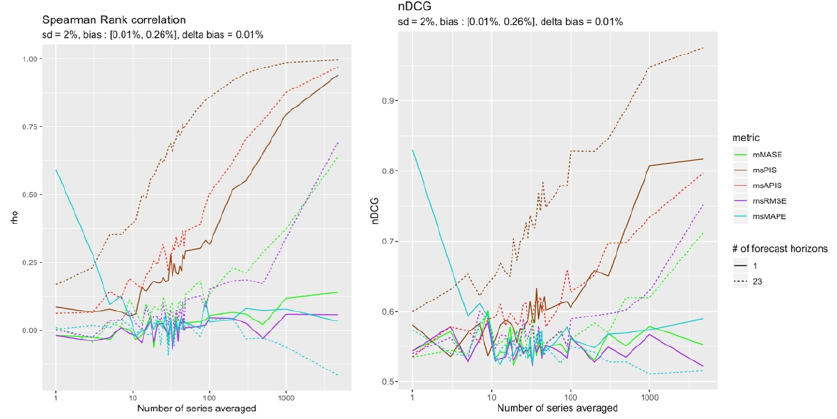
Figure 17. Spearman Rank correlation and nDCG for ( + − − )